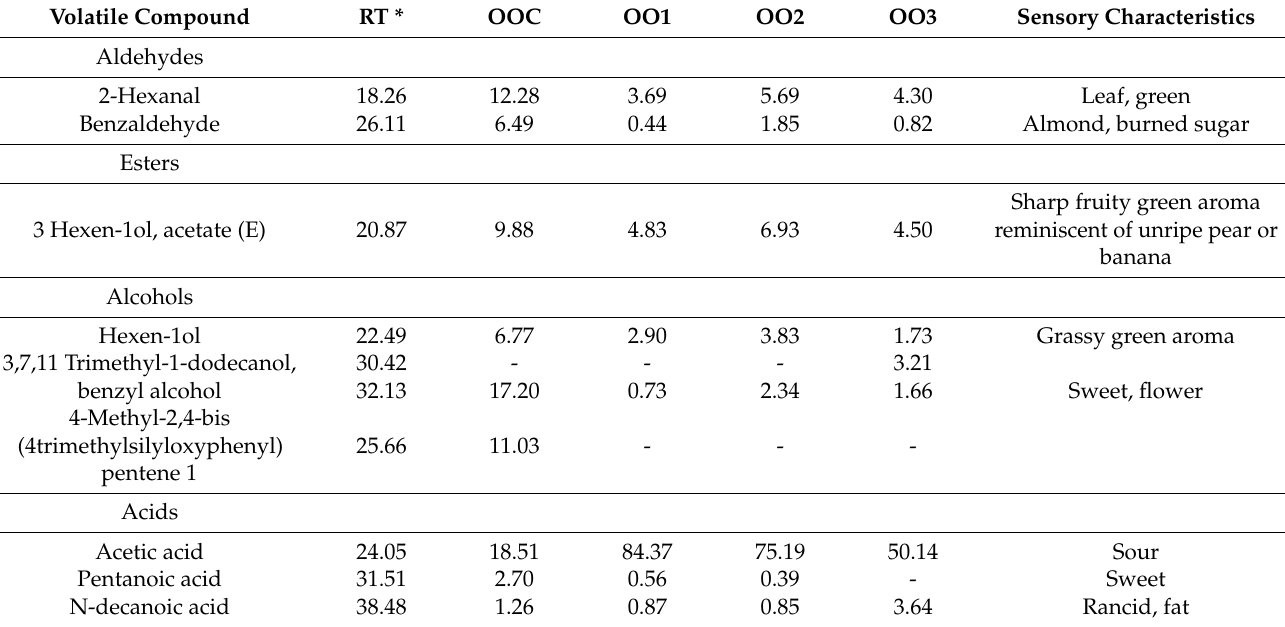
Table 7. The percentage of volatile compound peak areas in the experimental samples with olive oil.